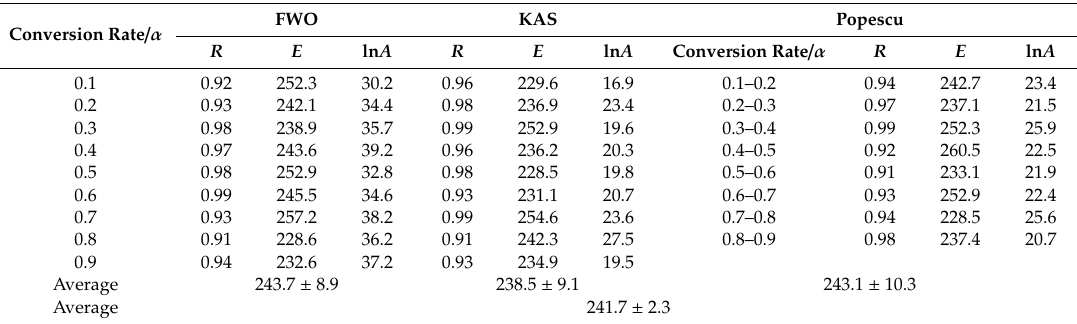
Table 3. The results of R, E and ln A of clotted part.